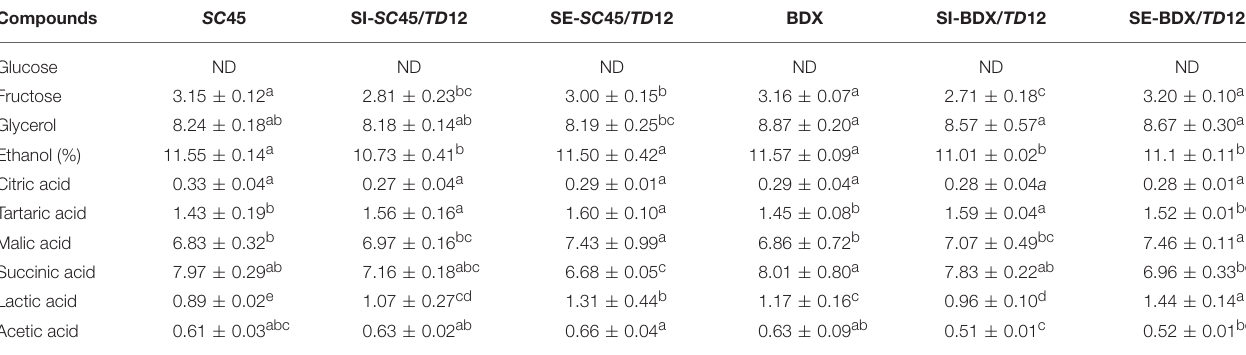
TABLE 1 | Analytical parameters (g/L) of the final wines after alcoholic fermentation. Compounds